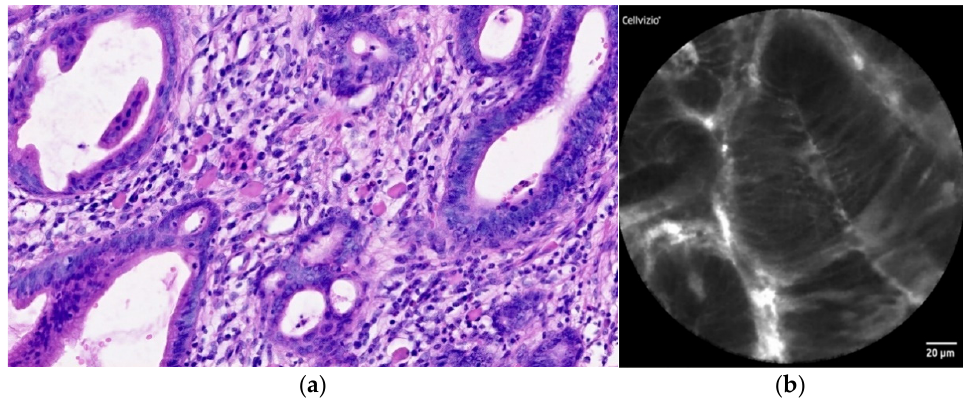
Figure 4. ( a ) Histopathology: EAC consisting of tubular and cribriform glandular formations with